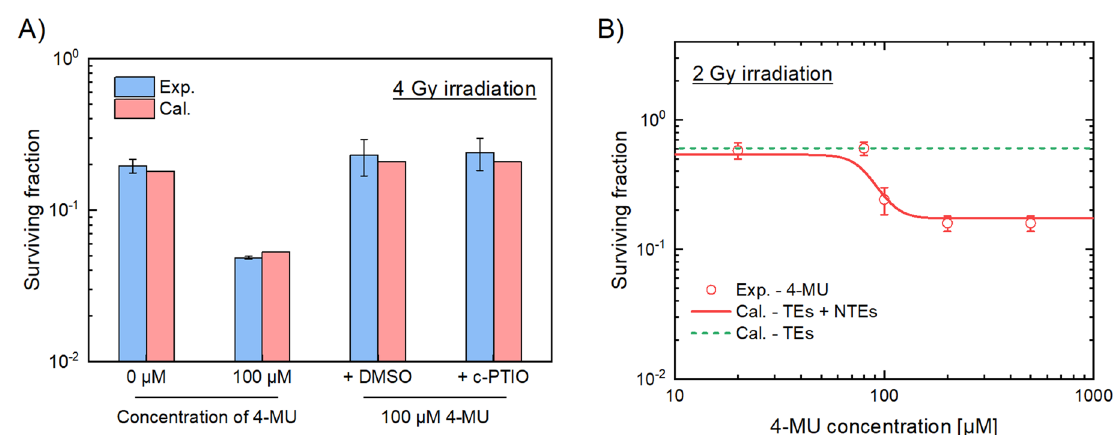
Figure 3. Additional verification of the IMK model in comparison with the experimental data. ( A ) The surviving fraction of HT1080 cells was treated with the 100 μM 4-MU and the ROS inhibitor (1% DMSO) or NO inhibitor (40 μM c-PTIO). We estimated surviving fraction based on the IMK model and the model parameters listed in Table 1. ( B ) The surviving fraction as a function of the 4-MU concentration with a constant 2 Gy irradiation. Red solid line represents the surviving fraction estimated by the IMK model, red circle the experimental cell survival treated with the 100 μM 4-MU, and green dot line the cell survival estimated by the IMK model considering only